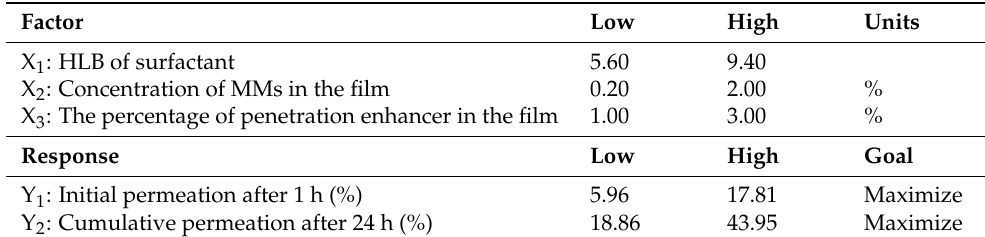
Table 1. Box–Behnken design attributes, involving factors and their selected levels with responses and their constraints and goals.